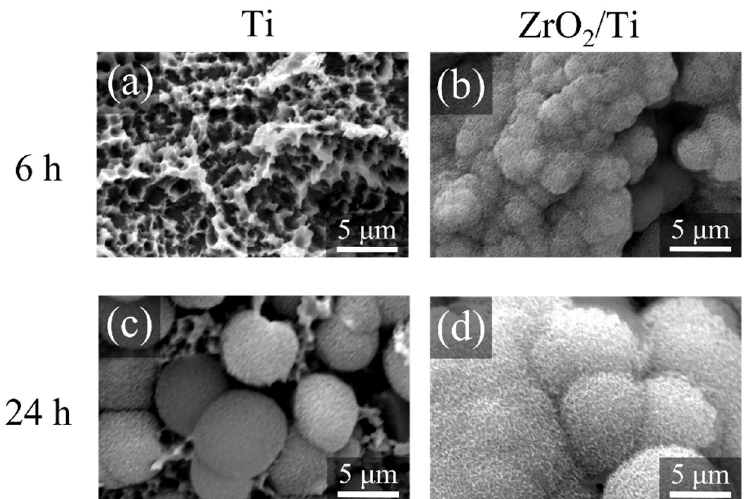
Figure 11. SEM profiles of the surfaces of the Ti and ZrO 2 /Ti disks after SBF immersion. ( a , c ) Ti and ( b , d ) ZrO 2 /Ti disks. ( a , b ) 6 and ( c , d ) 24 h after immersion.